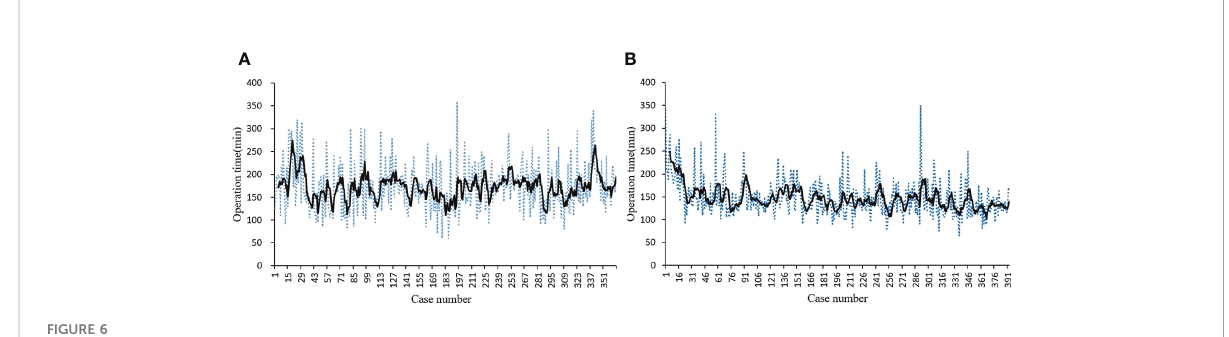
FIGURE 6 Learning curve. (A) Learning curve for ET-BAA; (B) Learning curve for